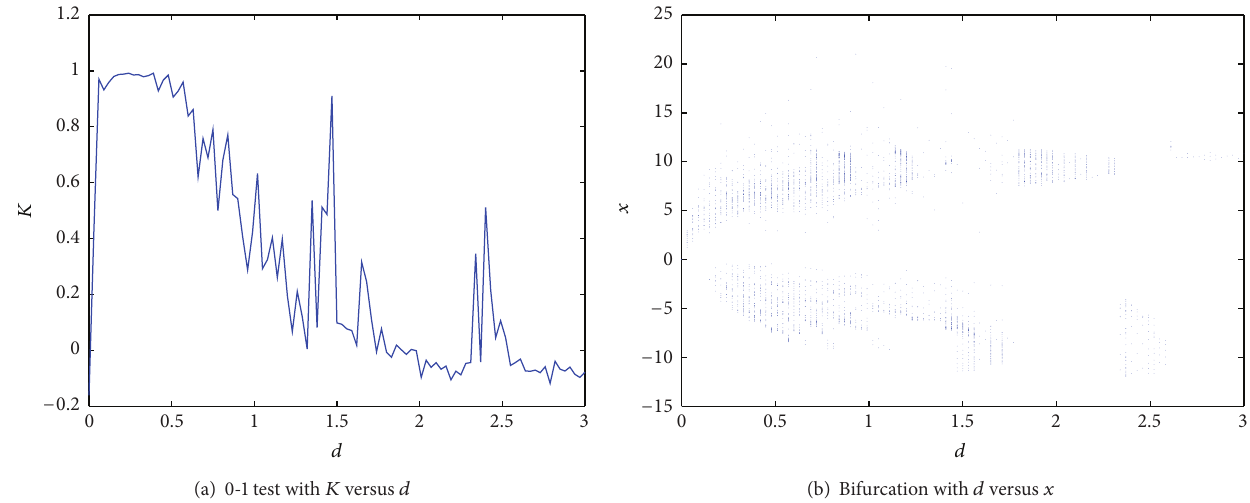
Figure 1: The evolvement of 𝐾 and 𝑥 versus 𝑑 with 𝑞 1 = 0.96 , 𝑞 2 = 0.94 , 𝑞 3 = 0.92 , 𝑞 4 = 0.78 , 𝑎 = 3 , 𝑏 = 0.4 , and 𝑐 = 0.4 .